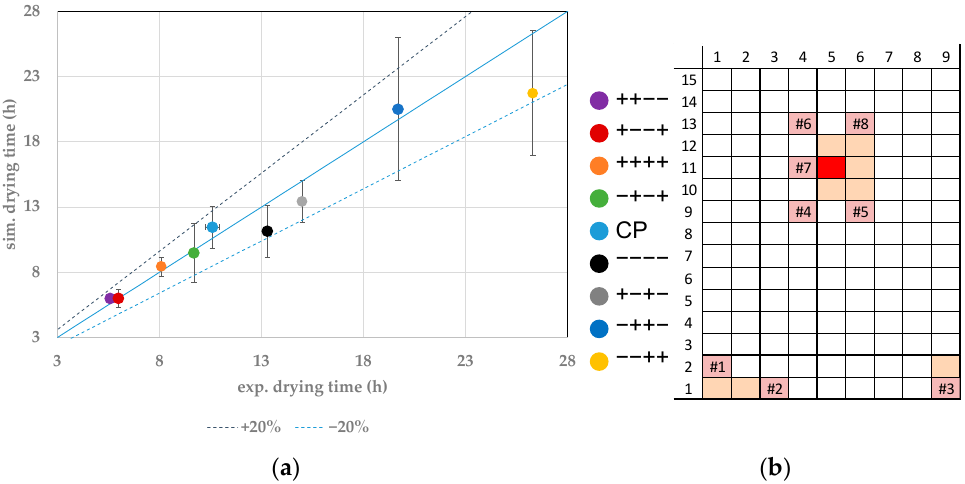
Figure 6. ( a ) Parity plot between simulated and experimental primary drying endpoints for vial 11.5. ( b ) Color legend for experiments and vial position (red: shown vial, orange: other probed vials, pink: WTMplus sensor position and WTMplus number).